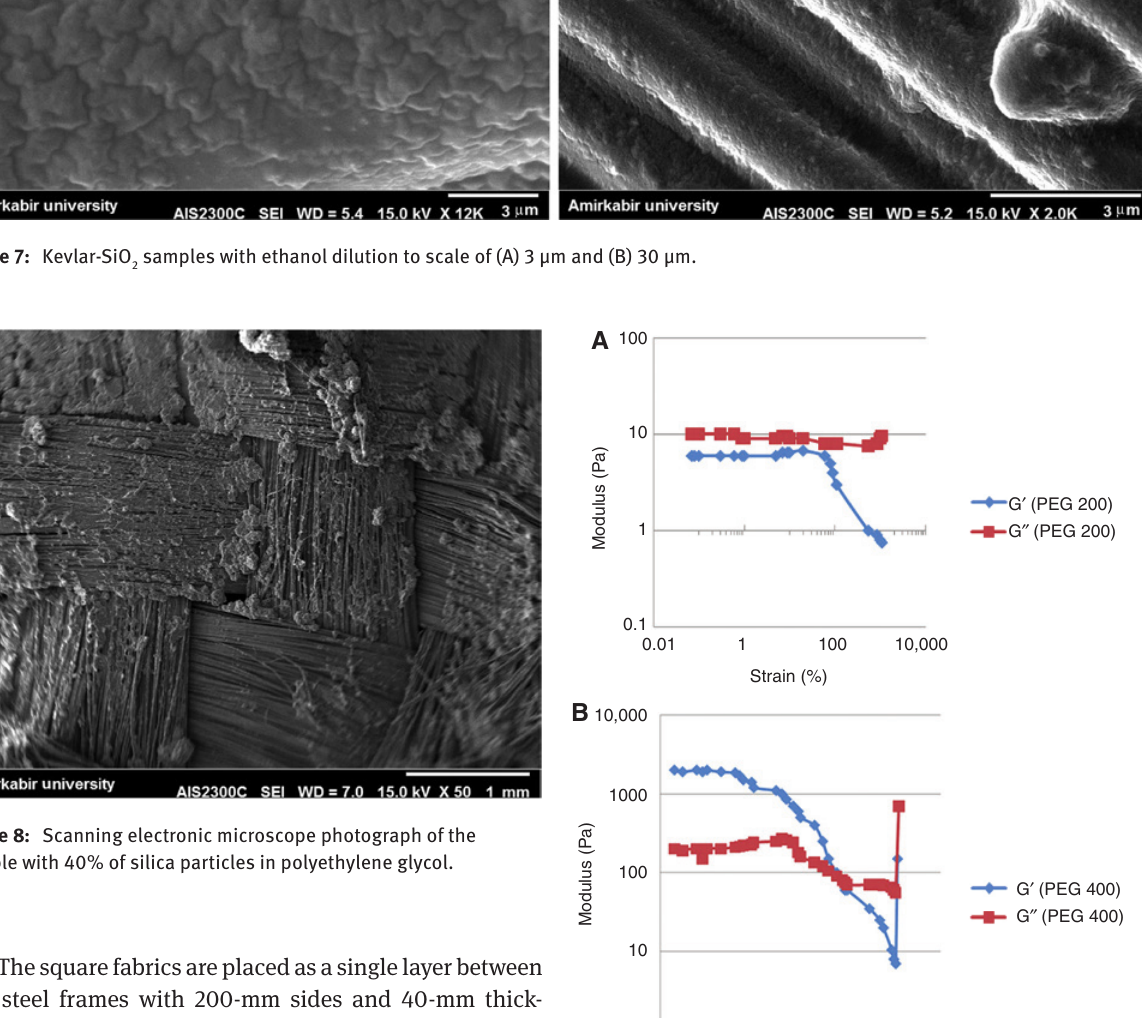
The square fabrics are placed as a single layer between two steel frames with 200-mm sides and 40-mm thick- ness. The diameter of the interior circle in the middle of the two metal plates is 127